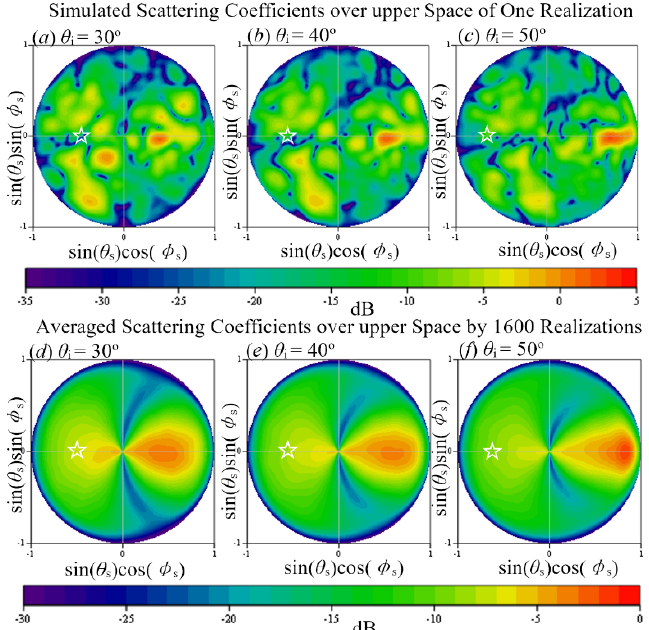
Figure 12. Results of simulated bi ‐ static scattering coefficients over the upper space, considering different incident angle θ i . The backscattering angular position is marked by the white ‐ lined star. Sample and computation parameters are in Tables 1 and 3(set 1).